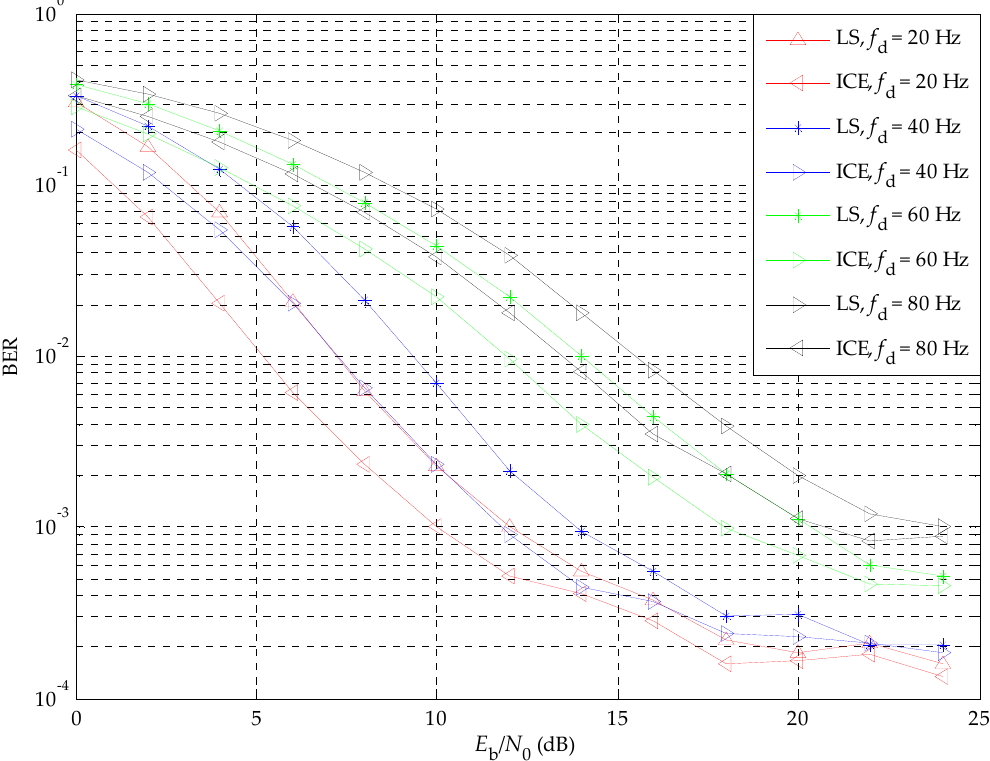
Figure 10. BER performance of OFDM/16-QAM system over Rayleigh fading channels with Doppler spread of 20, 40, 60, and 80 Hz.